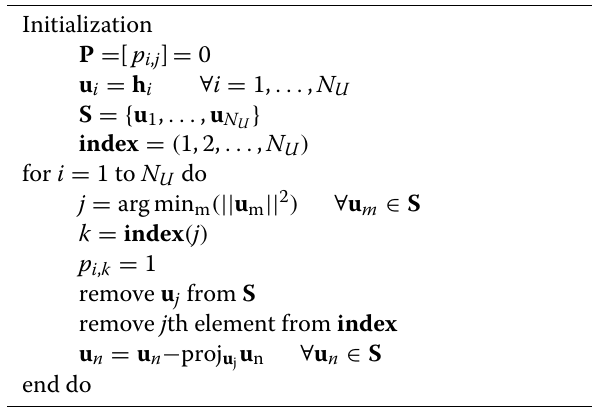
Algorithm 1 (SNR,P) RC algorithm